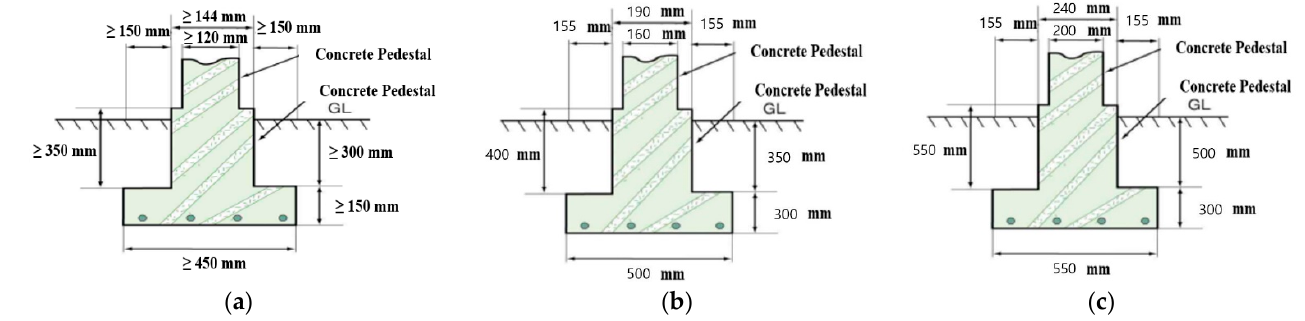
Figure 4. ( a ) KGS FP127 model dimension with 120 mm protection wall thickness; ( b ) Model dimension with 160 mm protection wall thickness; ( c ) Model dimension with 200 mm protection wall thickness.